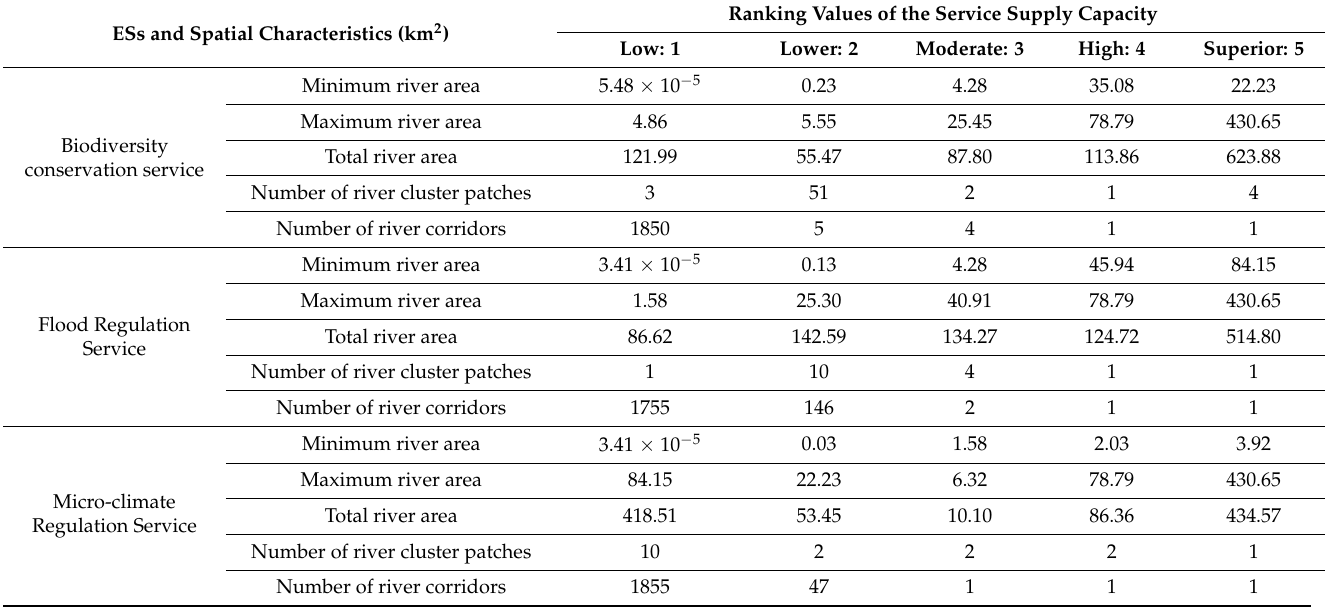
Table A4. Descriptive statistics of spatial analysis results of five crucial ESs provided by water linear spaces. ESs and Spatial Characteristics (km 2